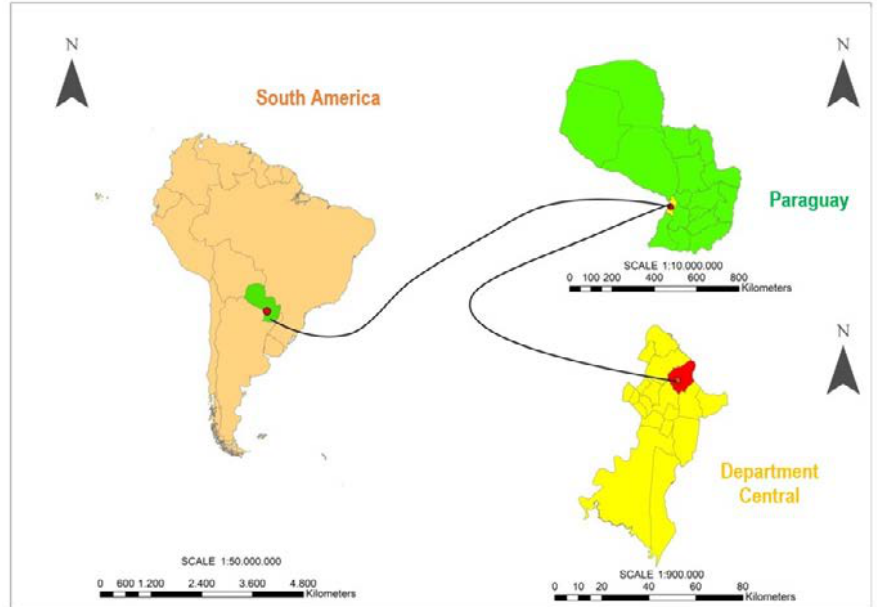
Fig. 1: Geographic location of the study area inYpacaraí Lake, Municipal Park of Aregua, Central Department, Paraguay